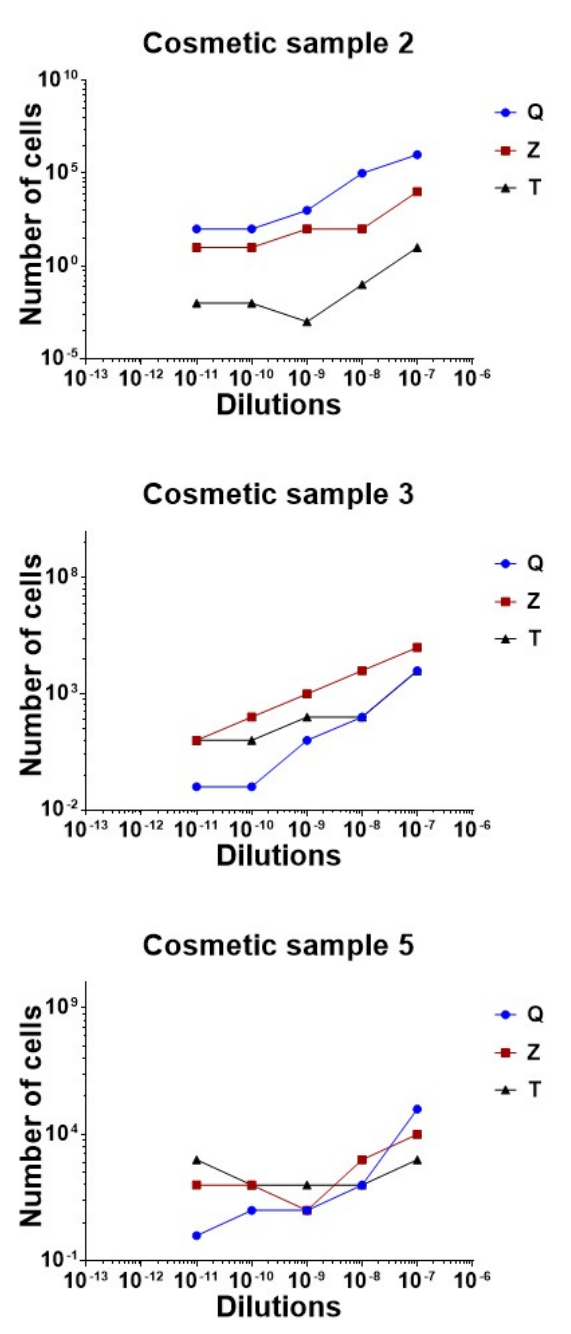
Figure 5. Comparison between DNA recovery obtained by the DNeasy Power soil kit from Qiagen (Q, in blue), the Zymo Research Quick DNA Fungal Bacterial DNA kit (Z, in red), and the MagMax Microbiome Ultra Nucleic Acid Isolation kit (T, in black), in cosmetic samples 2, 3, and 5 from dilution 10 −7 to 10 −12 (blank).